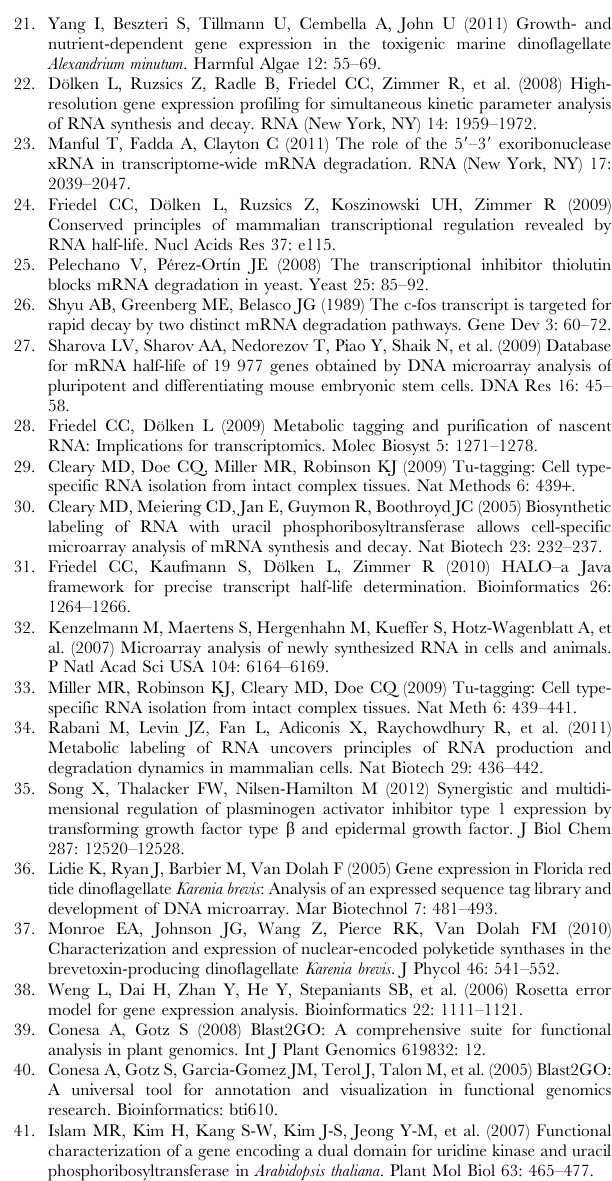
Figure S2 Karenia brevis mRNA half-lives calculated from additional ratios. Following 2 h incubation with 0.2 mM